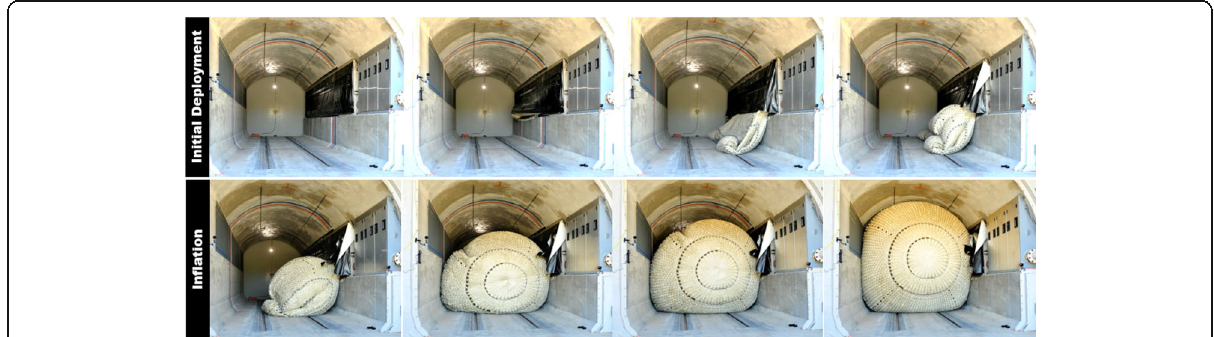
Fig. 14 Phase 3, full-scale testing, three-layer Vectran plug. A sequence of initial deployment from softcover container followed by pressurization with air inflation before flooding simulation [91,